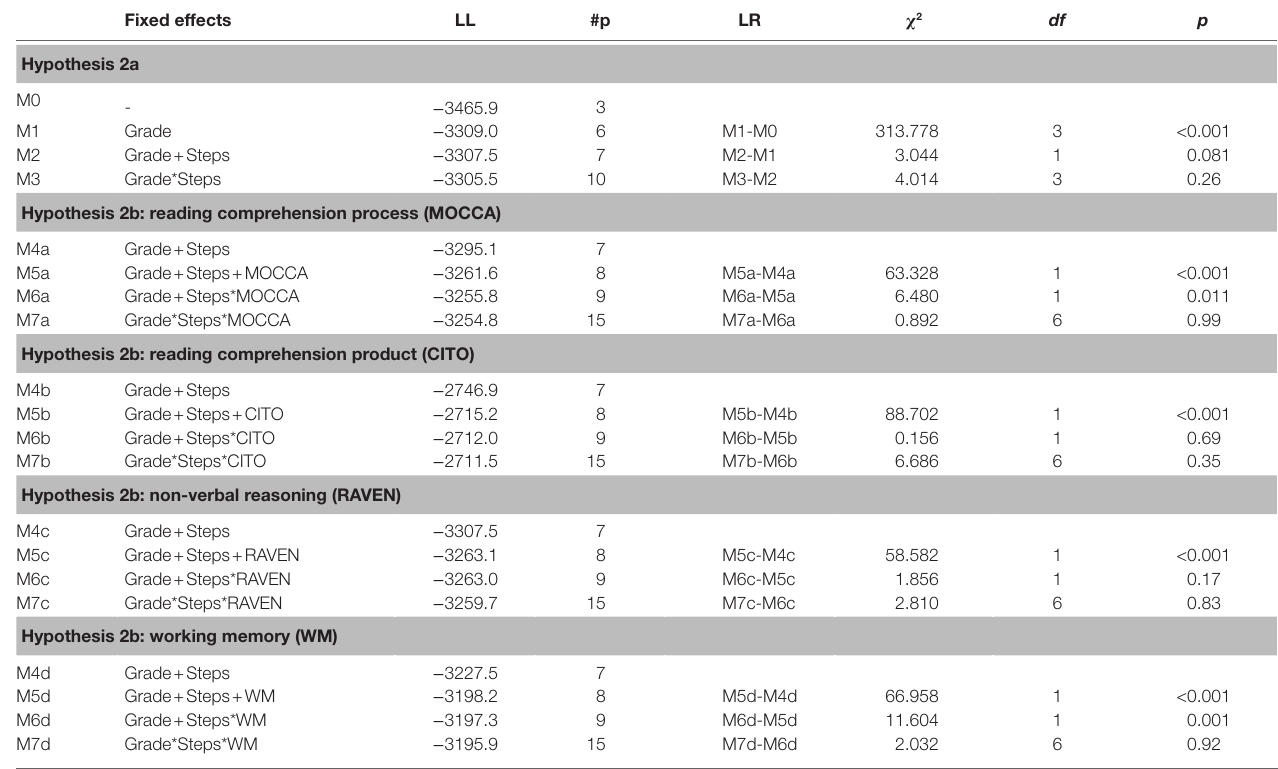
TABLE 5 | Statistical tests for research question 2: two-step versus one-step word problems. Fixed